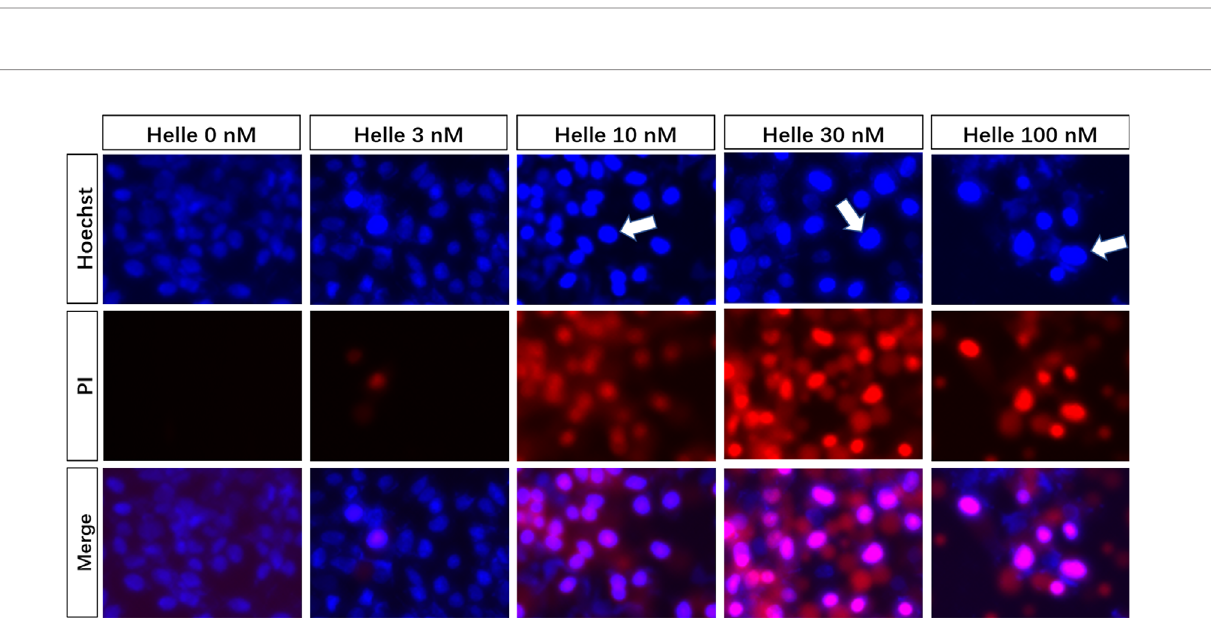
FIGURE 3 | Phenotypic features of cell death in MCF-7 cells treated by Helle. After treatment with various concentrations of Helle (3, 10, 30 and 100 nM) for 48 h, the phenotypic features of cell death were evaluated using the Hoechst 33342 (blue)/PI (red) staining as described in Materials and methods. Cells with condensed nuclei (arrows) and red fl uorescence were identi fi ed as those undergoing apoptosis and necrosis, respectively. The pink fl uorescence represents the merged images of Hoechst 33342 and PI. Images were captured using a BZ-X800 Keyence fl uorescence microscope and Leica X software at 100 × magni fi cation. Helle,